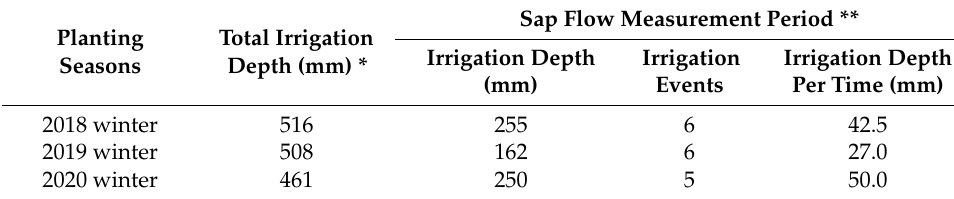
Table 2. Irrigation amount and irrigation events for three winter seasons.